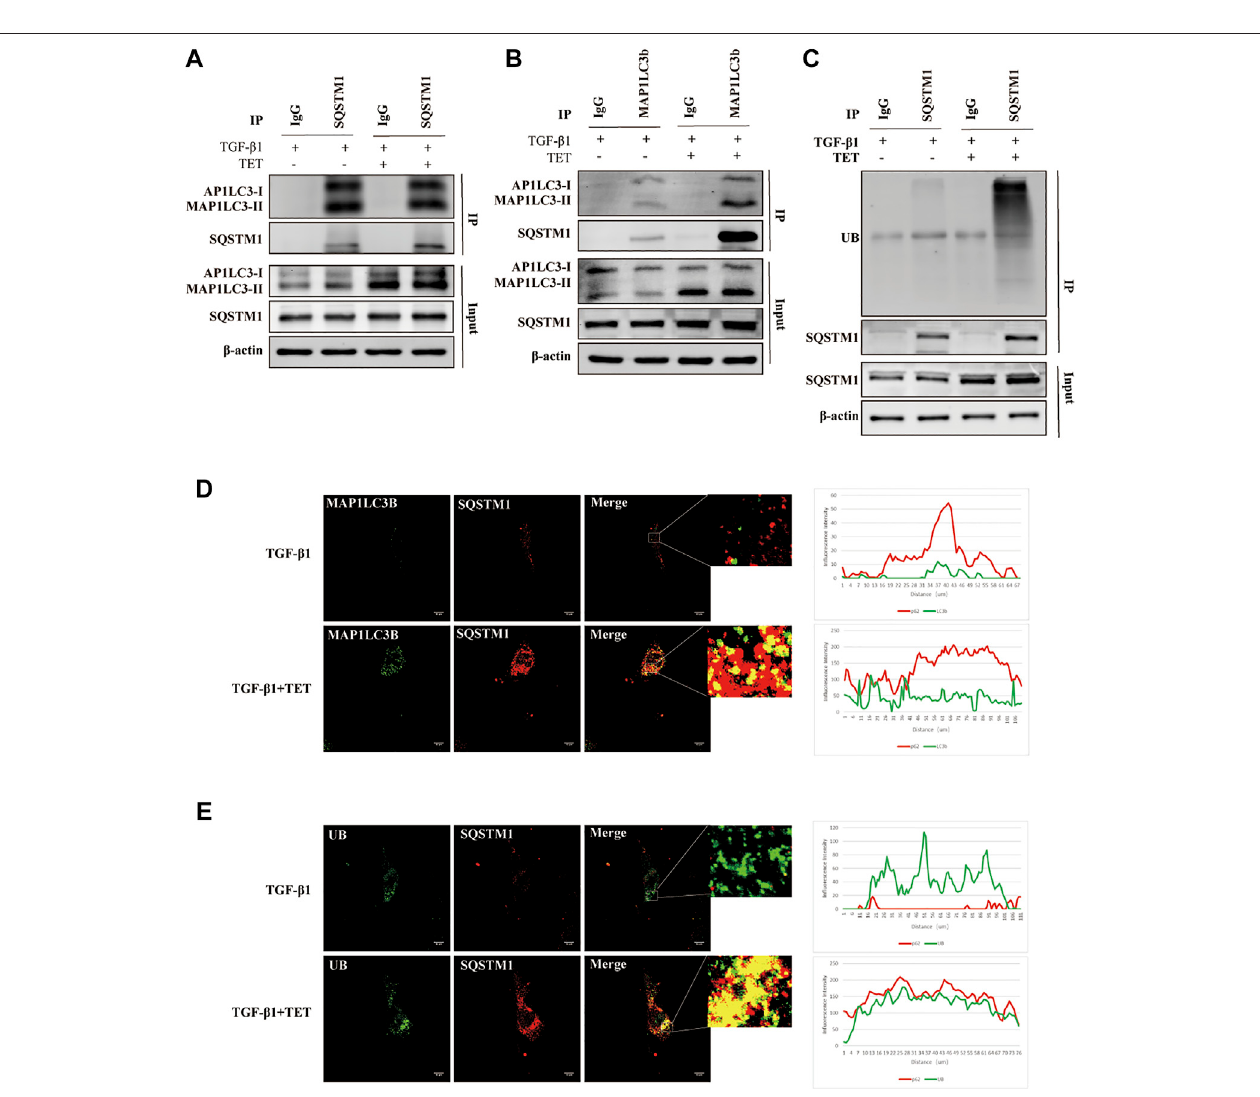
FIGURE 4 | TET promotes the interaction of SQSTM1 with MAP1LC3B and with ubiquitinated protein. Primary MLFs were pretreated with TET or DMSO for 1 h andthensubsequentlystimulatedwithTGF- β 1for24 h. (A,B) Co-immunoprecipitation(Co-IP)assayswithSQSTM1andMAP1LC3-I/II.Samplesbefore(Input)andafter (IP) immunopuri fi cation were analyzed by immunoblotting using SQSTM1 and MAP1LC3-I/II antibodies. (C) Co-IP assays with SQSTM1 and ubiquitinated protein. Samples were analyzed by immunoblotting using SQSTM1 and ubiquitin (UB) antibodies. (D) Confocal microscopy analysis of co-localization of MAP1LC3B and SQSTM1 in primary MLFs. The representative single optical sections and merge images are shown in the right panel. In these representative images, MAP1LC3B is visualized in green, SQSTM1 in red. Scale bars: 10 μ m. (E) Confocal microscopy analysis of co-localization of UB and SQSTM1. Scale bars: 10 μ m. UB is visualized in green, SQSTM1 in